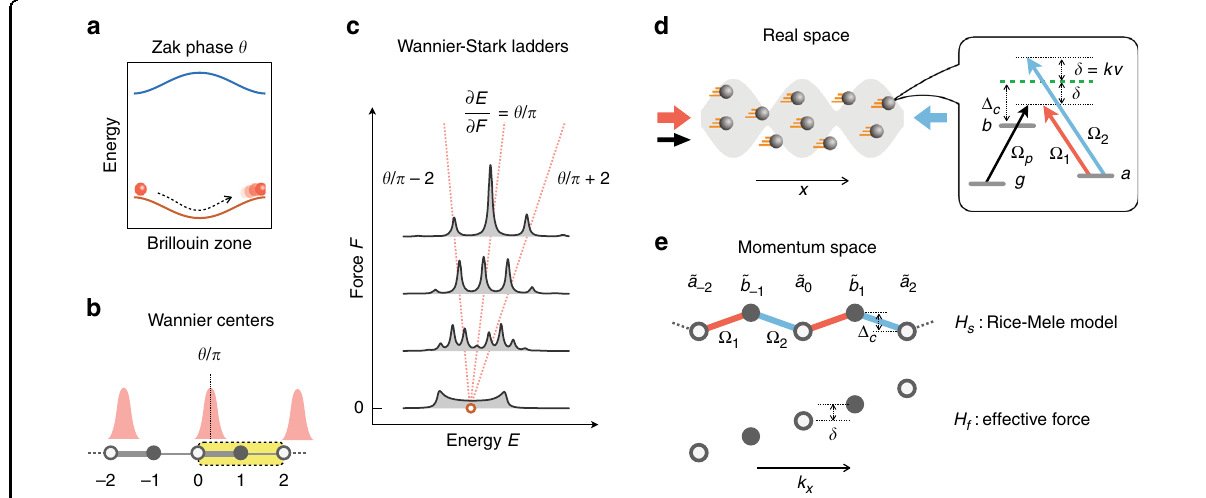
Fig. 1 Relation between Zak phases and Wannier-Stark ladders in superradiance lattices. a The Zak phase as an accumulated geometric phase of a particle adiabatically driven across a whole Brillouin zone. b The Wannier function in each unit cell. The zeroth unit cell is highlighted with yellow color. The positions of the Wannier centers are 2 n þ θ = π . c Schematic WSLs shown by the projected density of states with different forces F ¼ δ . The three dotted lines connect the corresponding WSLs in different forces. Quantum transport package Nanoskim 54 is used in the calculation. d Schematic con fi guration of the light fi elds. Inset: the coupling between the light fi elds and the atomic levels in the reference frame of the atom with the Rabi frequency Ω i ( i ¼ 1 ; 2 ; p ), the coupling fi eld detuning in the lab reference frame Δ c , and the Doppler shift δ . The shaded area indicates the envelope of the standing wave coupling fi eld and the balls indicate atoms with velocity v . e The momentum-space superradiance lattice with tight-binding Hamiltonian H s (upper) and a linear potential H f (lower). ~ d j d ¼ a ; b ð Þ are the timed Dicke